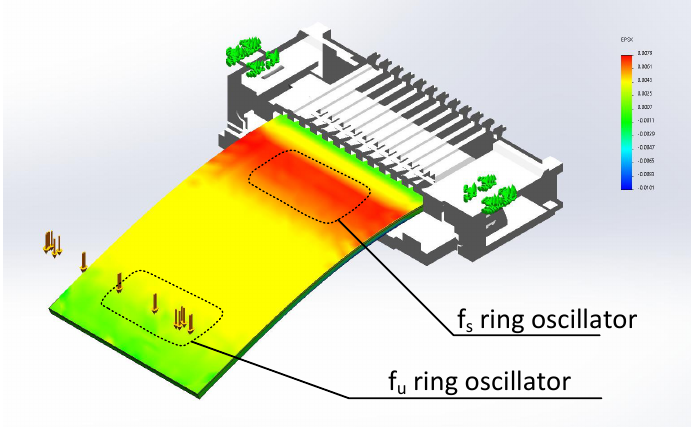
Figure 14. Mechanical stress simulation of the complete structure, bottom view. Ren- ders in Figures 13a,d and 14 based on Easy-On FFC/FPC Connector PN 505110-1297 STEP Model, courtesy of Molex